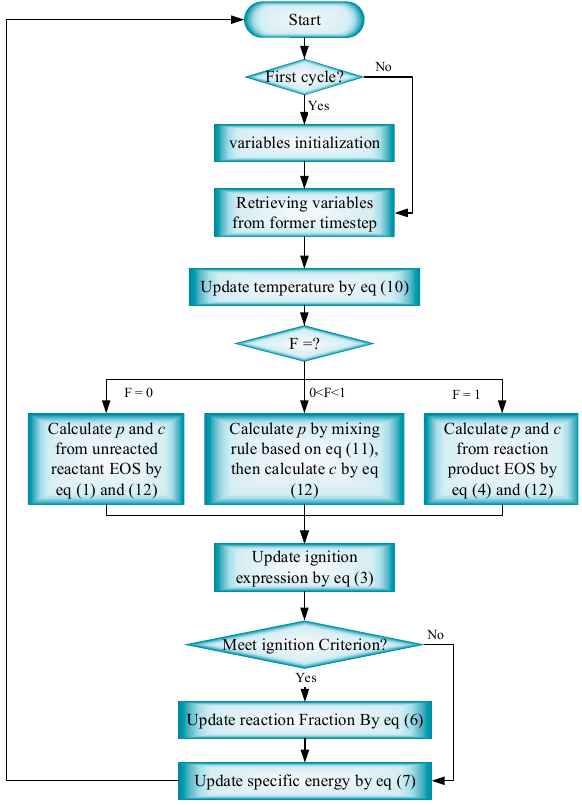
Figure 3. The solve loop of EOS subroutine.